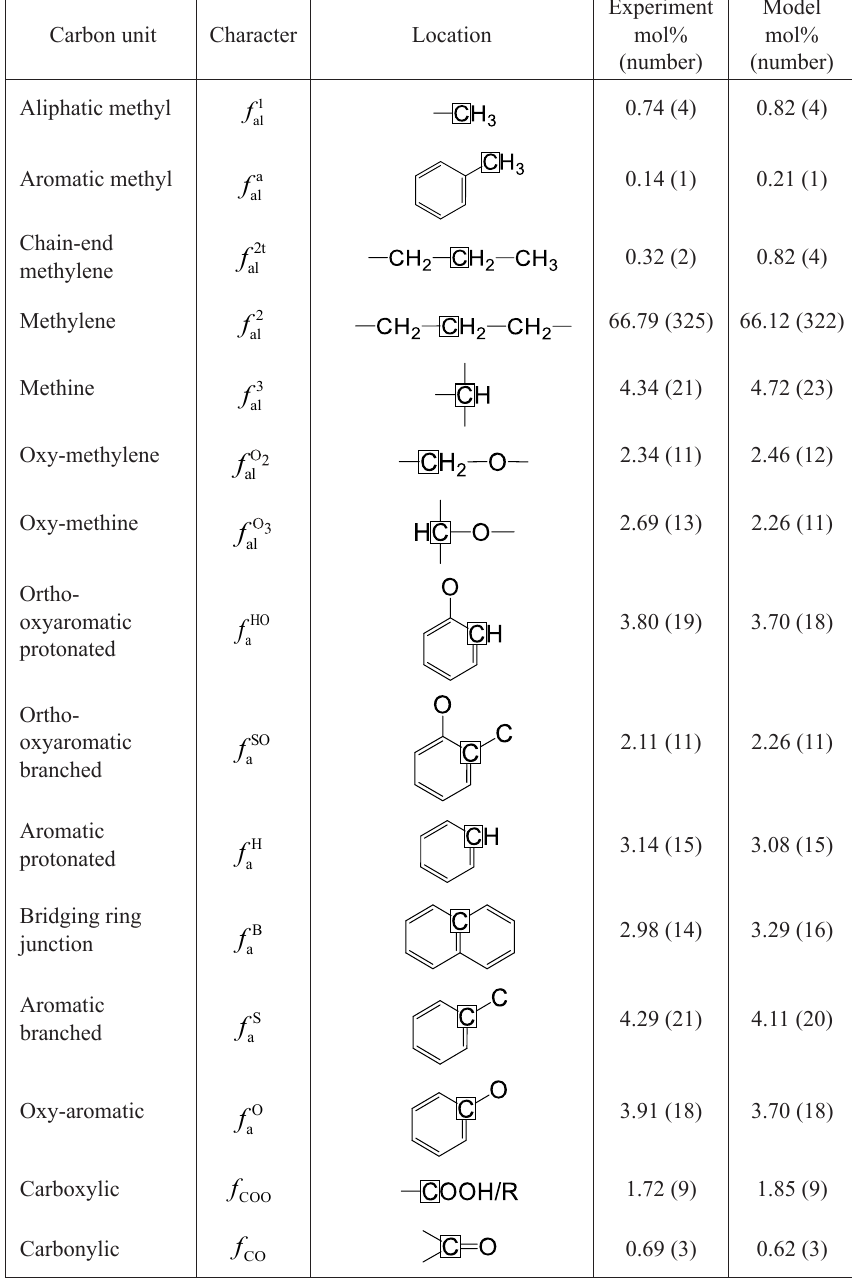
DP/MAS SSNMR spectrum [35] of Dachengzi oil shale kerogen.